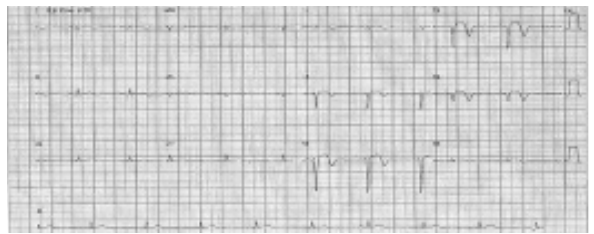
Fig. 1A - Pré-operatório